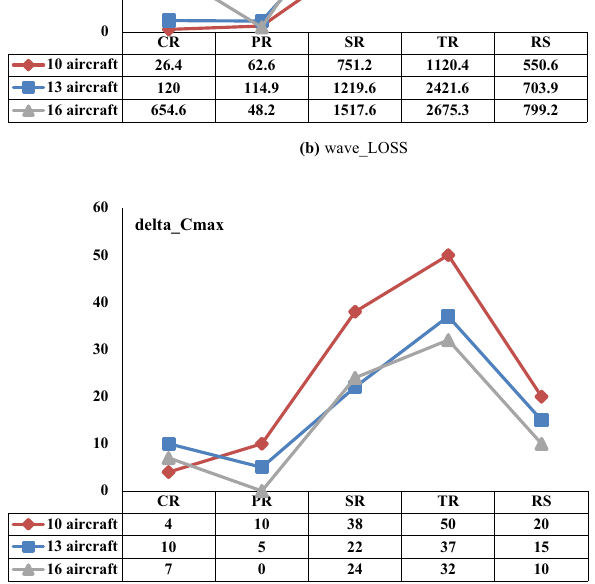
positive correlation was observed, in that the value of reac- tiveschedulingchange_ WAincreasedwiththeprocessdelay time and gradually entered the optimization bottleneck; the value of change_ WA was high, which triggered a decrease in the wave availability after reactive scheduling; the overall change of ROBU was not insignificant; the change_ WA and wave_ LOSS in event II of 13 aircraft conditions showed